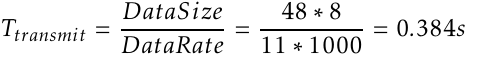
Figure 20. BPHs in rice field and sensor nodes in the beginning.